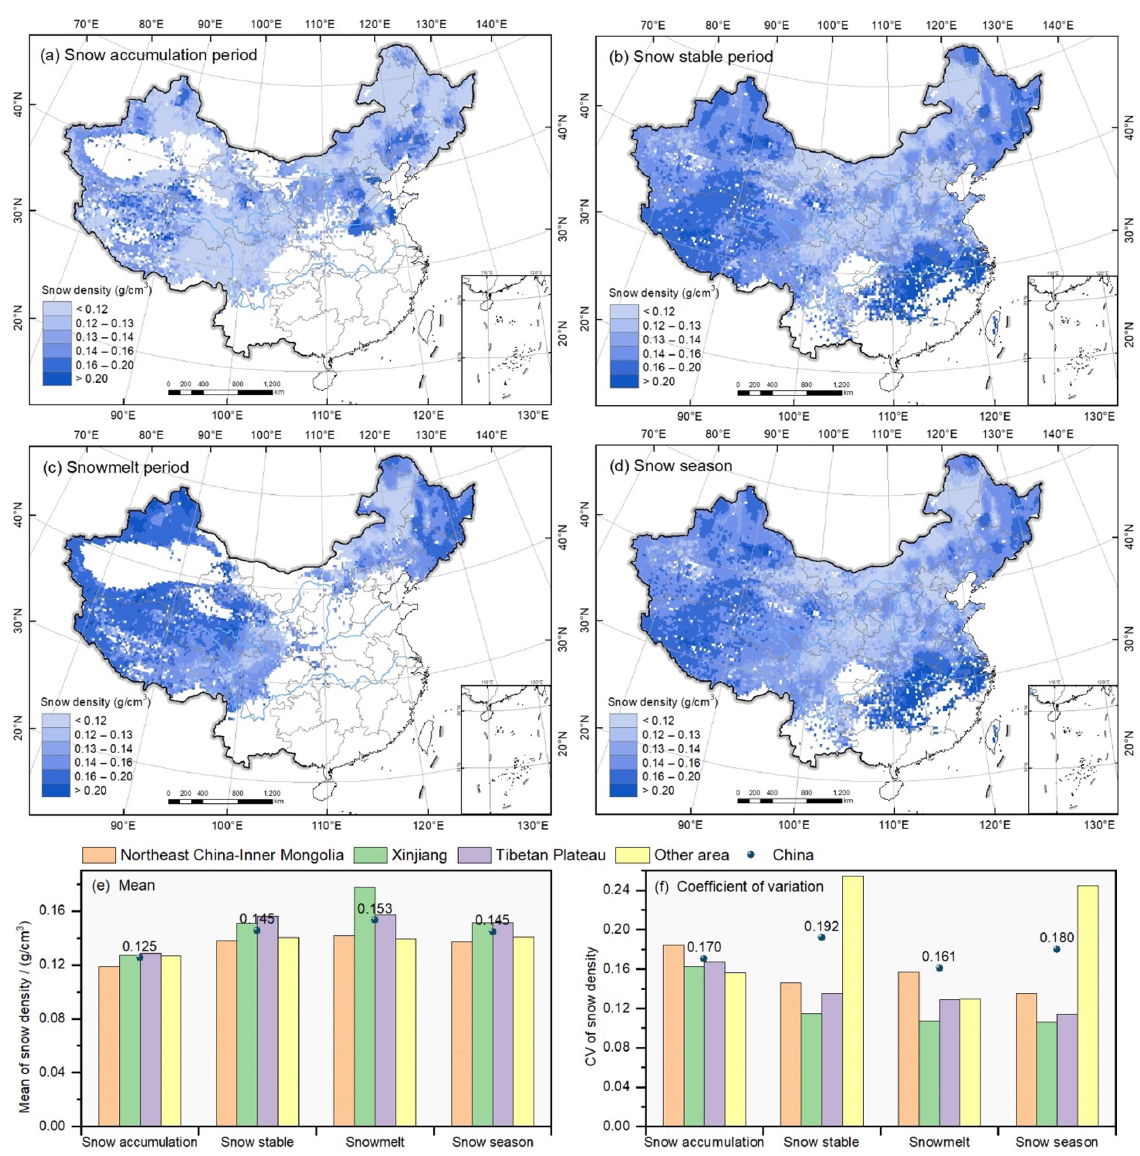
Figure 8. Spatial distribution of mean snow density in different snow periods in China from 2013 to 2020, including the snow accumulation period (a) , snow stable period (b) , snowmelt period (c) , and entire snow season (d) , as well as the mean snow density (e) and coefficient of variation (f) in different snow periods and snow cover